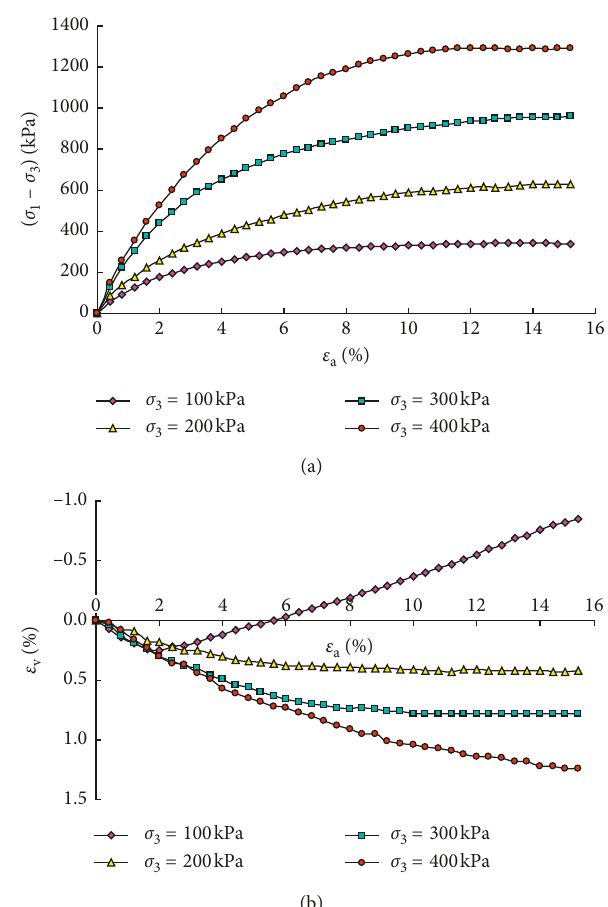
Figure 4: Relationship between stress and strain of typical gravelly